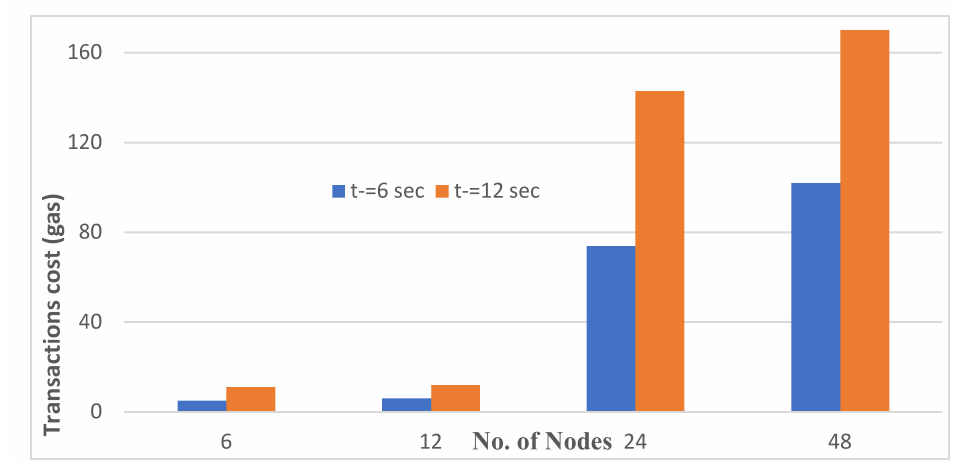
Figure 7. Transaction cost for BIoT-device-only type of